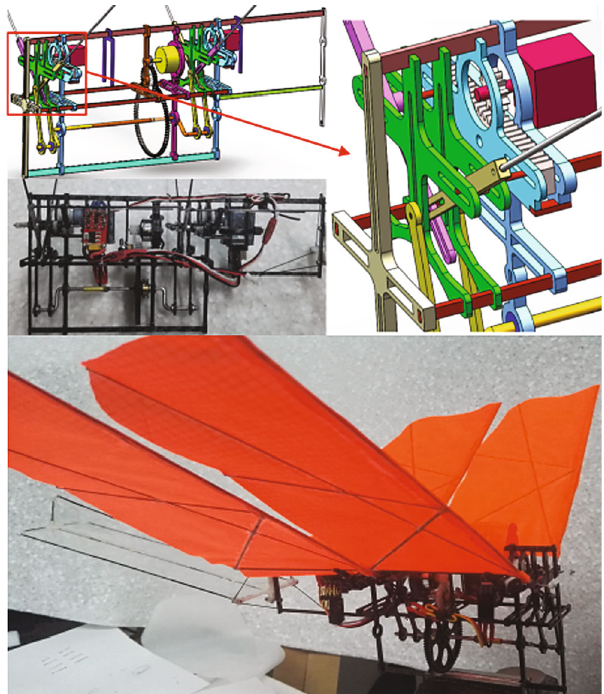
Figure 8: Three-dimensional FMAV model based on the SCSM.